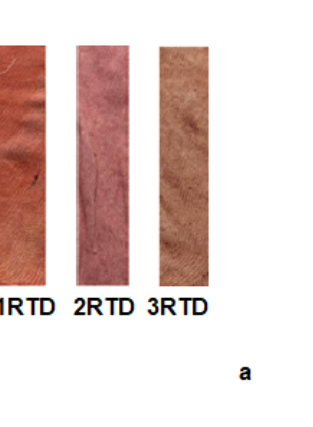
Figure 7. ( a ) Fabrics dyed with common madder with pre-mordanting, post-mordanting, and meta-mordanting (from left to right, respectively) and ( b ) K/S values of fabrics dyed with common madder with pre-mordanting, post-mordanting, and meta-mordanting. Table 9. Colorimetric values obtained for the samples dyed with common madder with tannin and alum as the mordants.